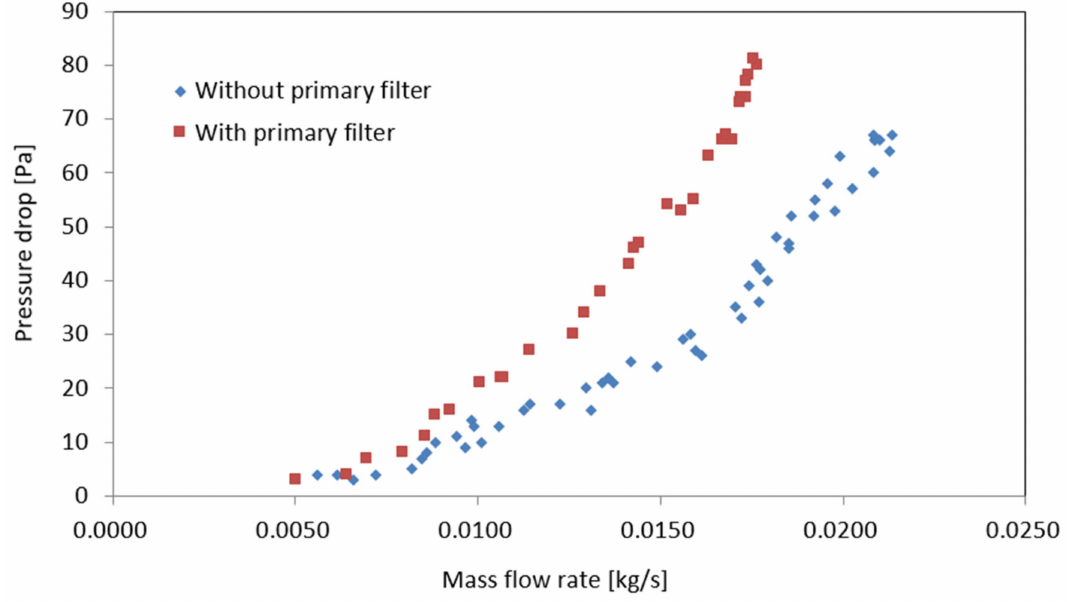
Figure 7. Flow resistance characteristics of primary filter element in air